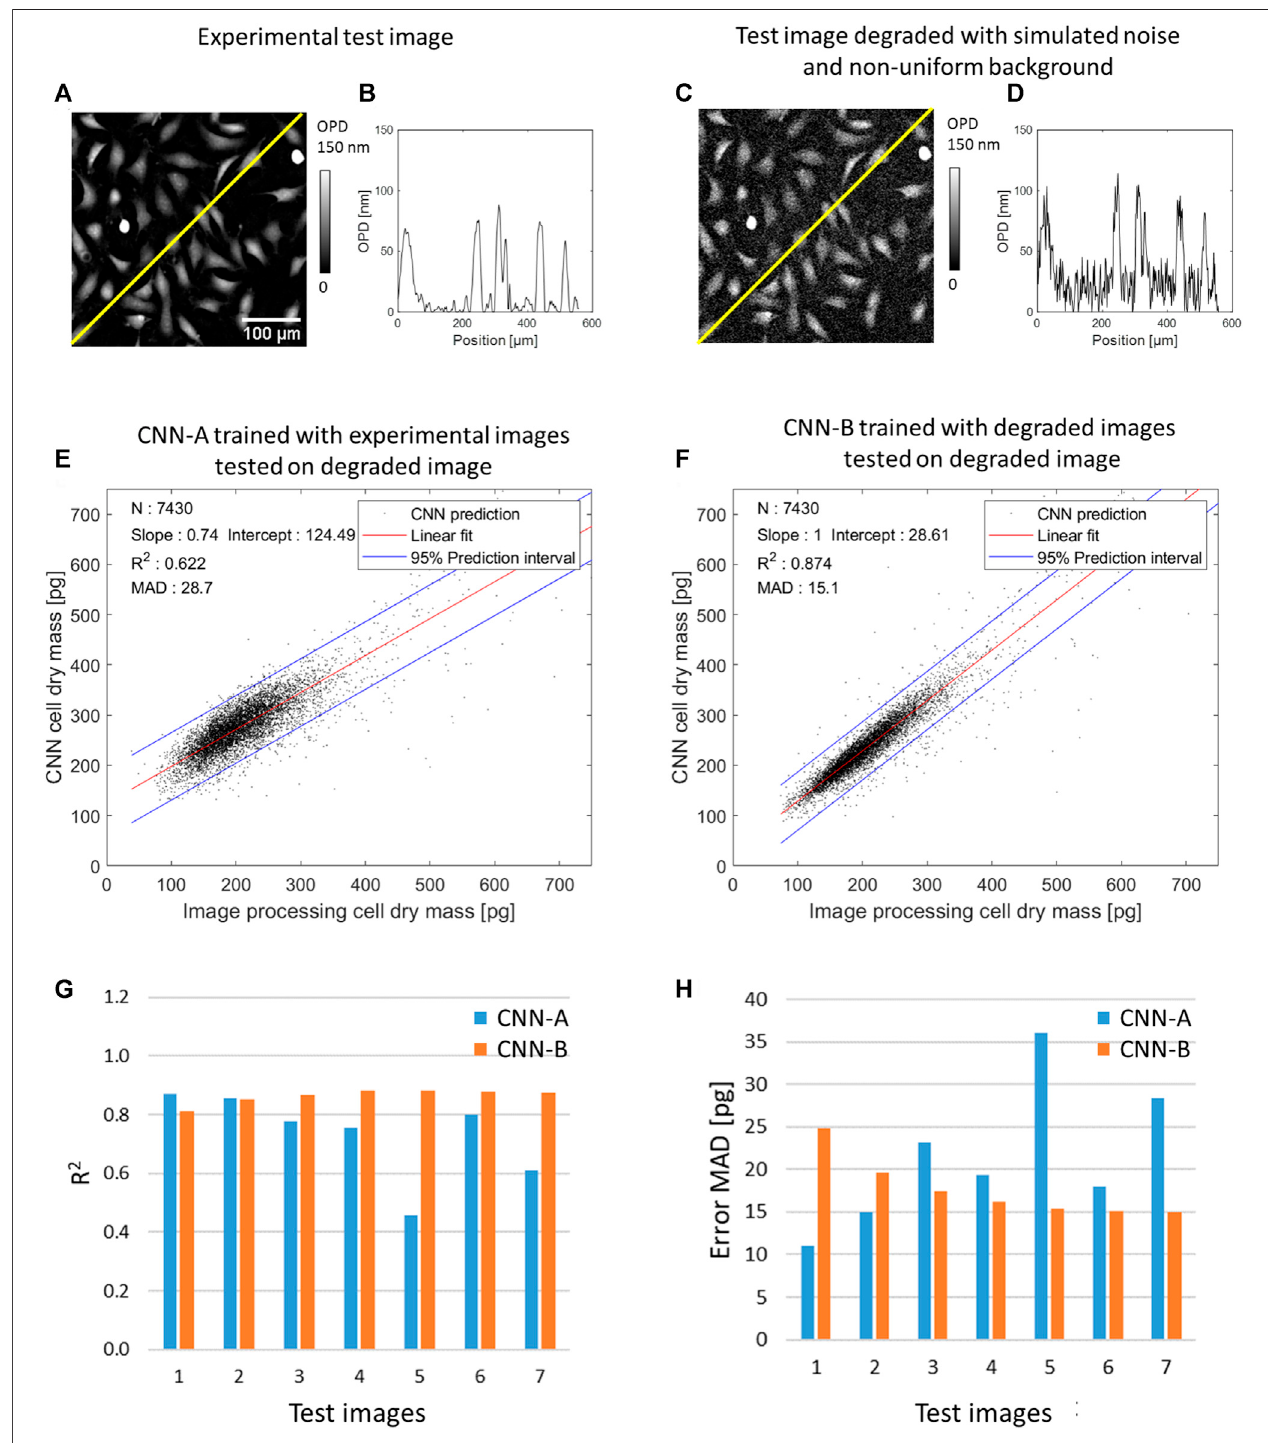
FIGURE 4 | Results of CNN-based quanti fi cation of cell dry mass applied to a test OPD image featuring 7,490 cells with and without numerical degradations. (A) Detail of the test experimental OPD image. (B) OPD pro fi le along yellow line in (A) . (C) Test OPD image degraded with simulated noise (20 nm spatial variation SD) and non-uniform background (30 nm maximum amplitude). (D) OPD pro fi le along yellow line in (C) . (E) CNN-A trained with images free of simulated degradation applied to the image numerically degraded (see (C, D) ), pair-wise comparison with the ground truth results over N (cid:1) 7,450 cells. (F) CNN-B trained with degraded images appliedtothedegradedimage,pair-wisecomparisonwiththegroundtruthresultsover N (cid:1) 7,450cells. (G) and (H) ResultsoftheevaluationtaskconductedwithCNN-A and CNN-Bover differentlevelsofimagequality(x7, see SupplementaryFigureS3 ). R 2 anderrorMAD( Eq.6 )arecalculatedonthepair-wise comparisonwithground